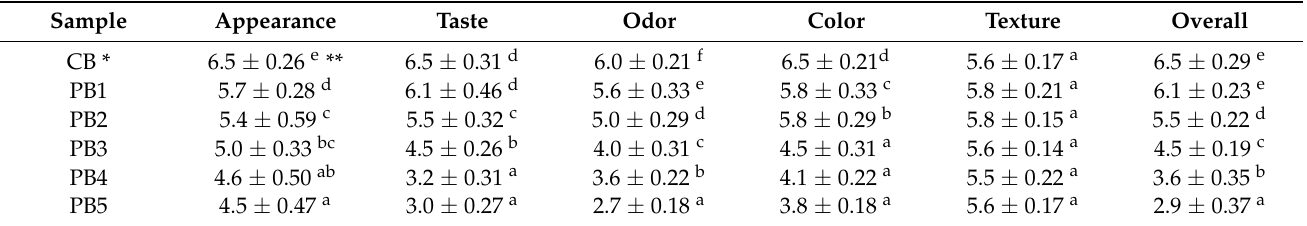
Table 4. The results of sensory evaluation of control bread and bread enriched with dried